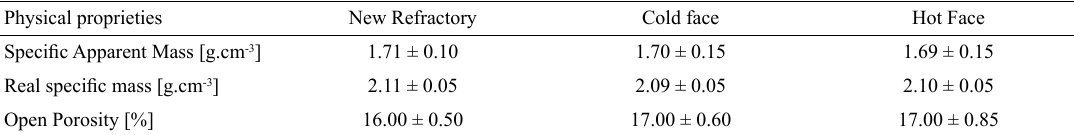
Table 1. Physical proprieties of the samples collected from the opposite side of the Tap Holes with standard deviation. Physical proprieties